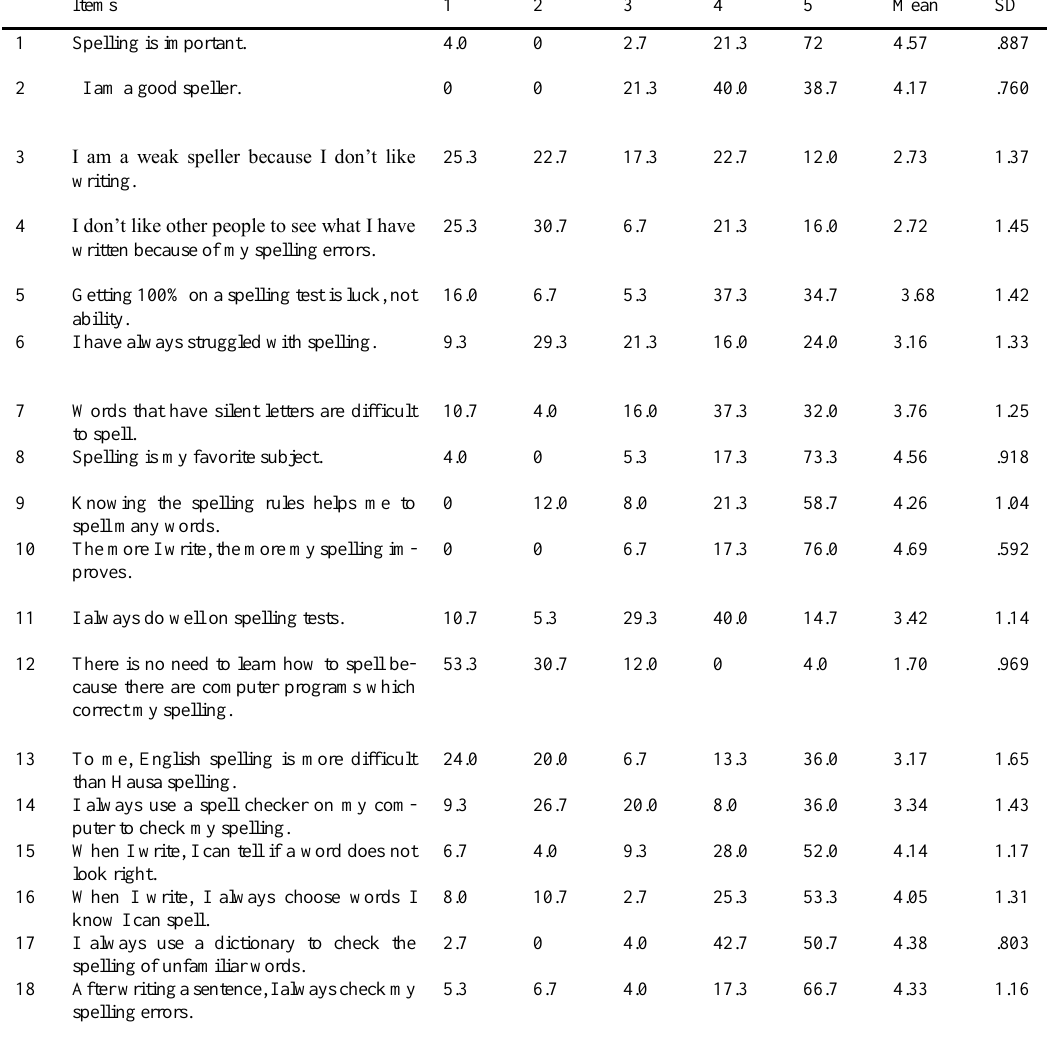
Table 1. Attitudes toward English